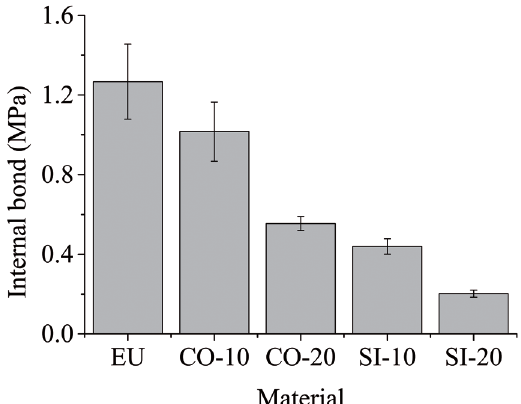
Figure 4: Histogram of the mean values for the internal bond property (IB). Bars indicate standard